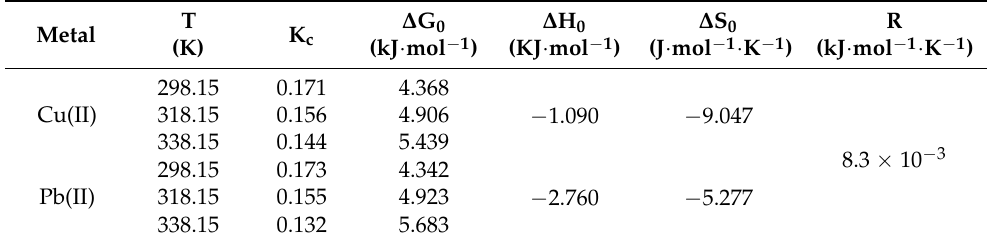
Table 5. Thermodynamic parameter of Cu(II) and Pb(II) adsorption by the obtained TA adsorbents.